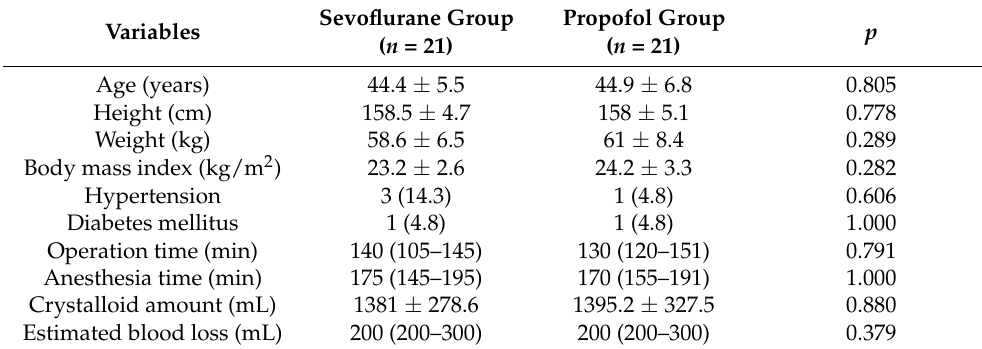
Table 1. Demographic and perioperative